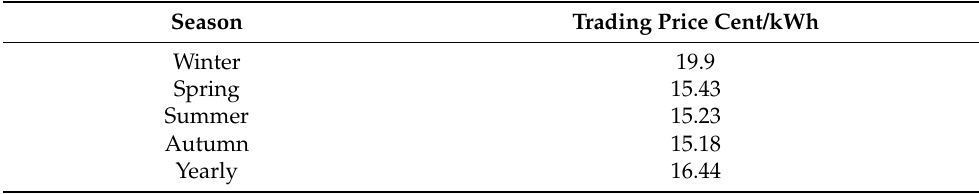
Table 7. Average trading price for loads each